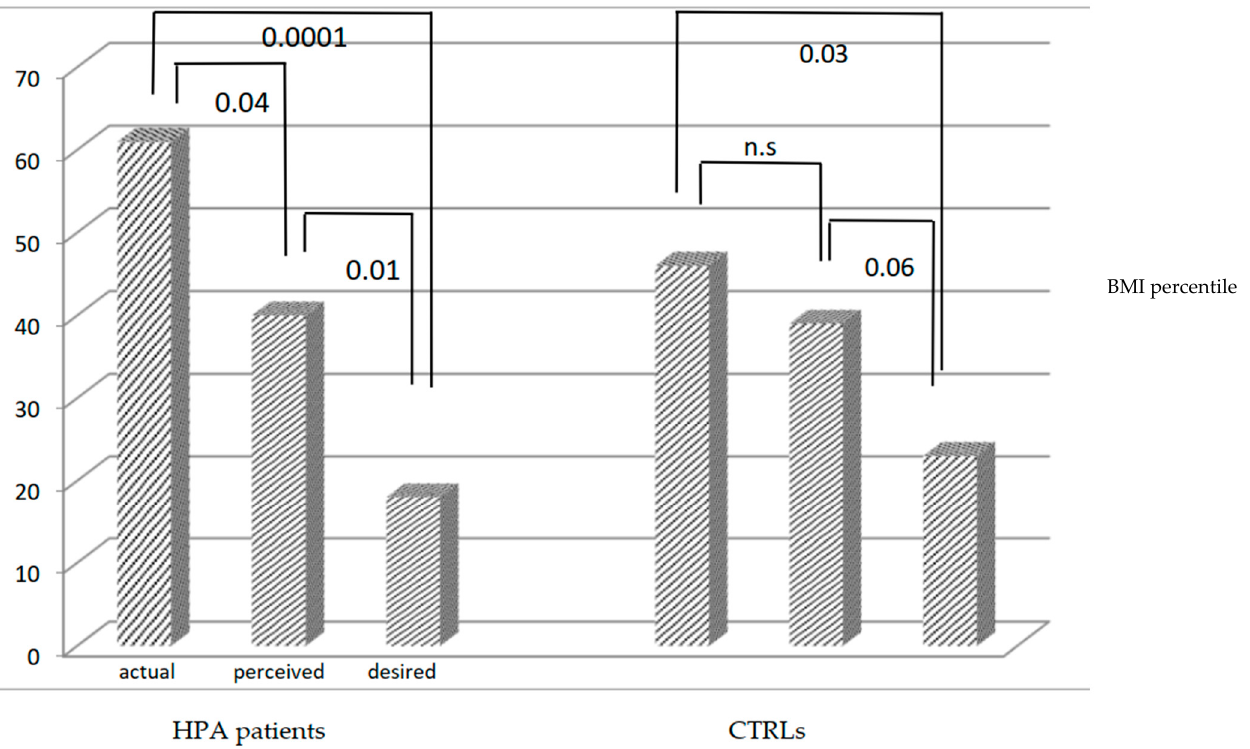
Figure 1. Differences among actual/perceived/desired BMI in HPA patients and controls. n.s. = not significant. HPA: Hyperphenylalaninemia; CTRLs: controls.